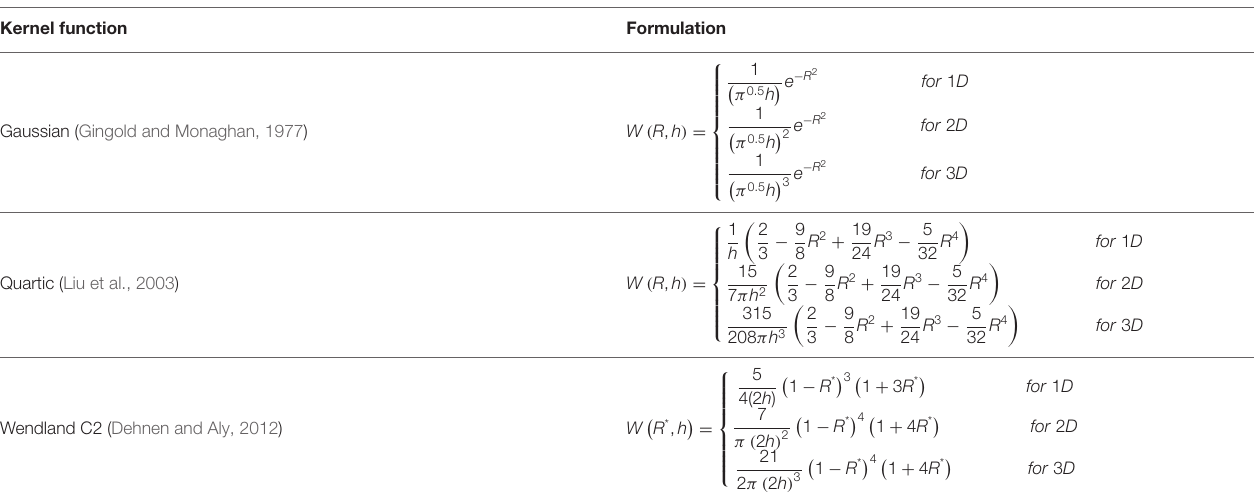
TABLE 1 | Commonly used SPH kernel functions